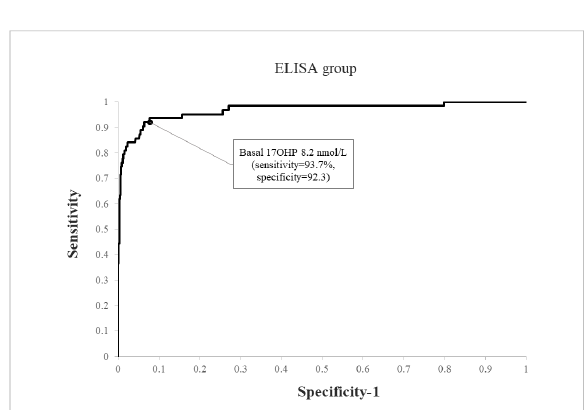
FIGURE 2 ROC curve analysis for determination of optimal basal 17OHP threshold in ELISA (using a post-CST 17OHP cutoff > 30 nmol/L for the diagnosis of NCCAH).